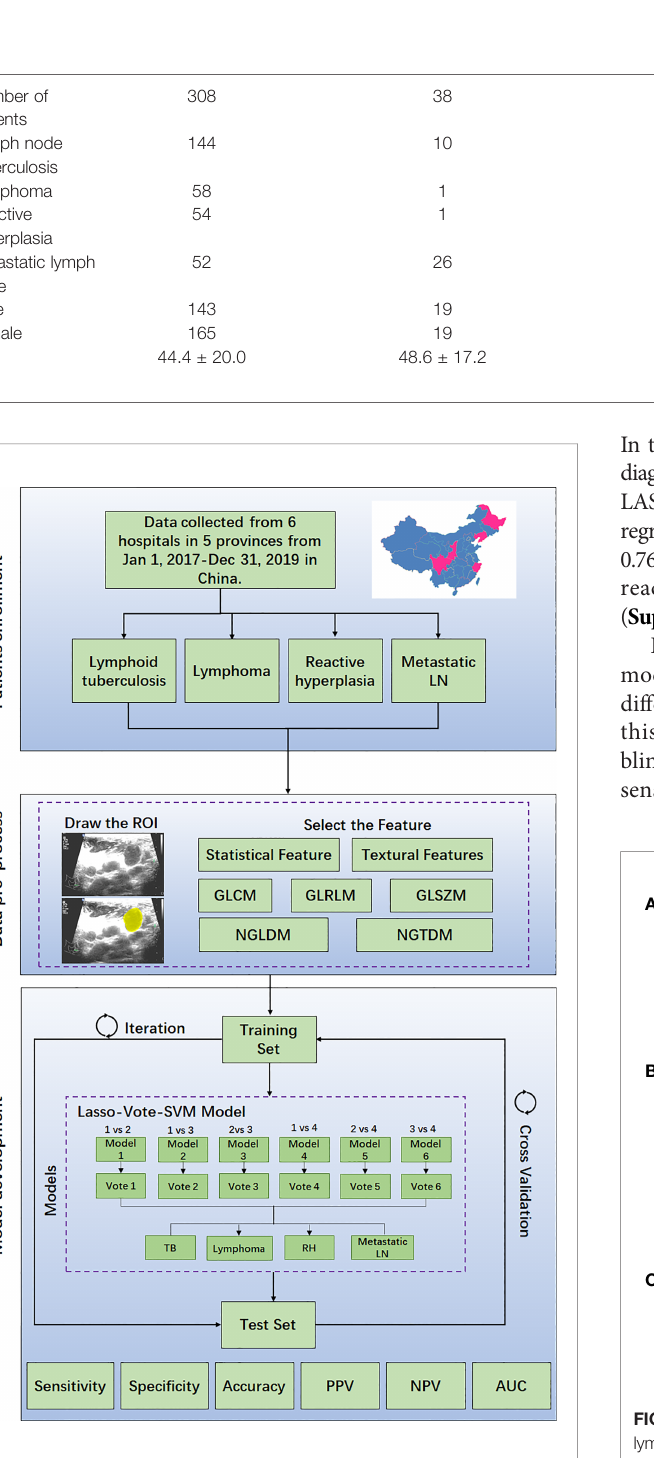
FIGURE 2 | Enrollment fl ow chart of this study.